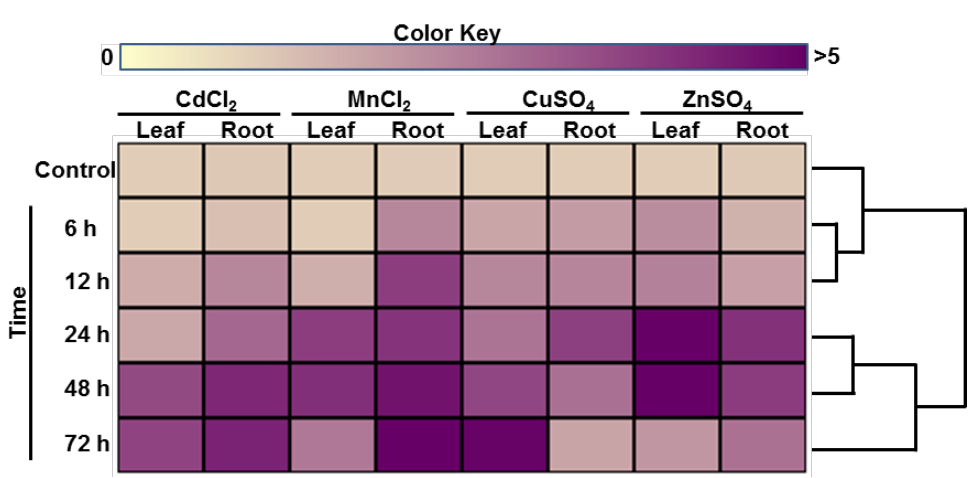
Figure 1. Heatmap of the LmTrxh2 gene expression profile in L. maritima subjected to different treatments. The dendrogram was constructed by hierarchical clustering of the expression values of the LmTrxh2 gene using the Euclidian distance metric. The data represent the means of three independent experiments.